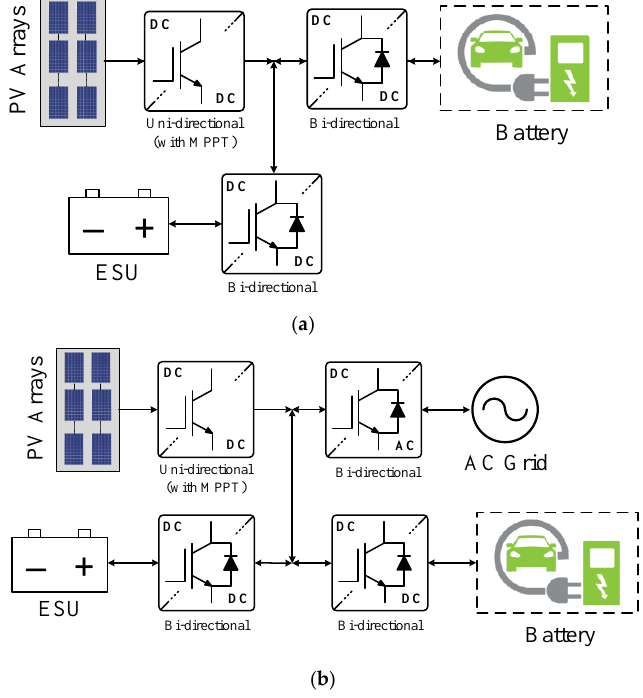
Figure 3. EV charging systems: ( a ) PV stand-alone (off-grid) and ( b ) PV-grid (on-grid).